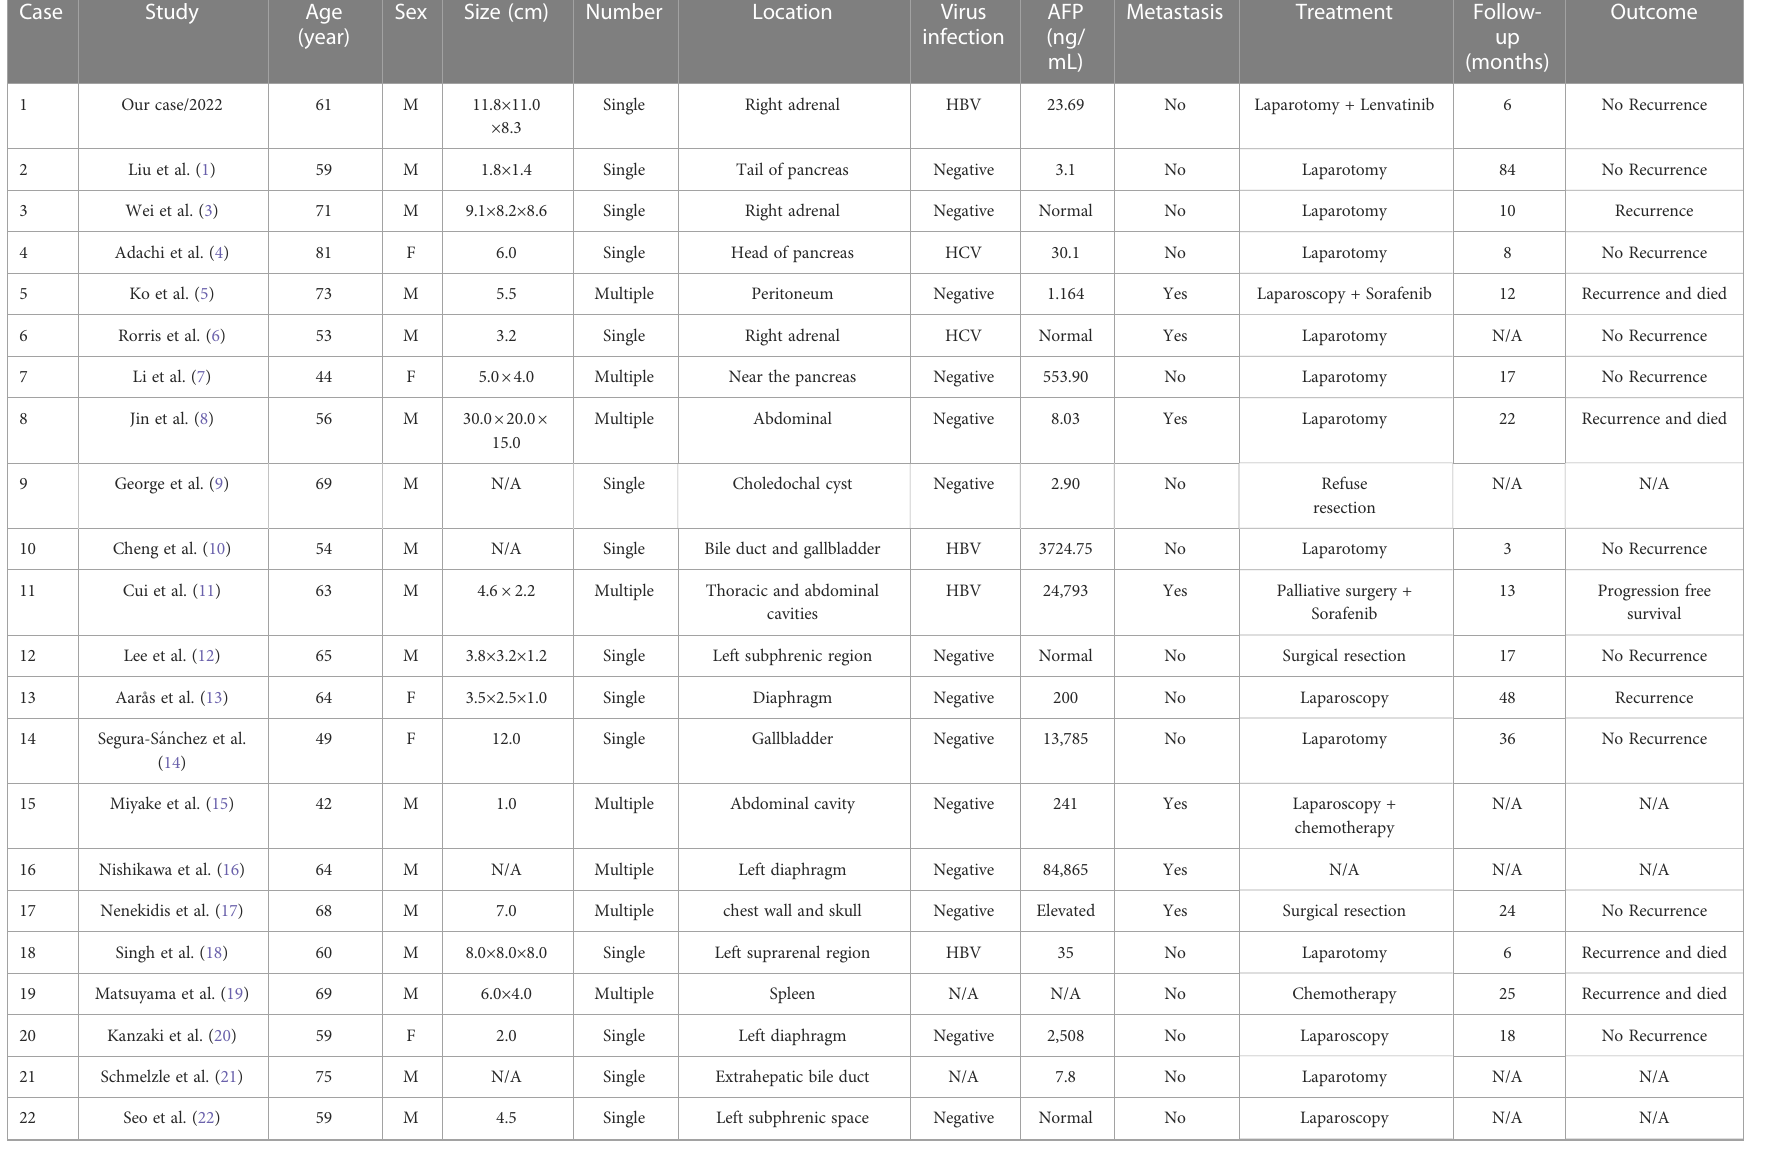
TABLE 2 Literature review of ectopic hepatocellular carcinoma